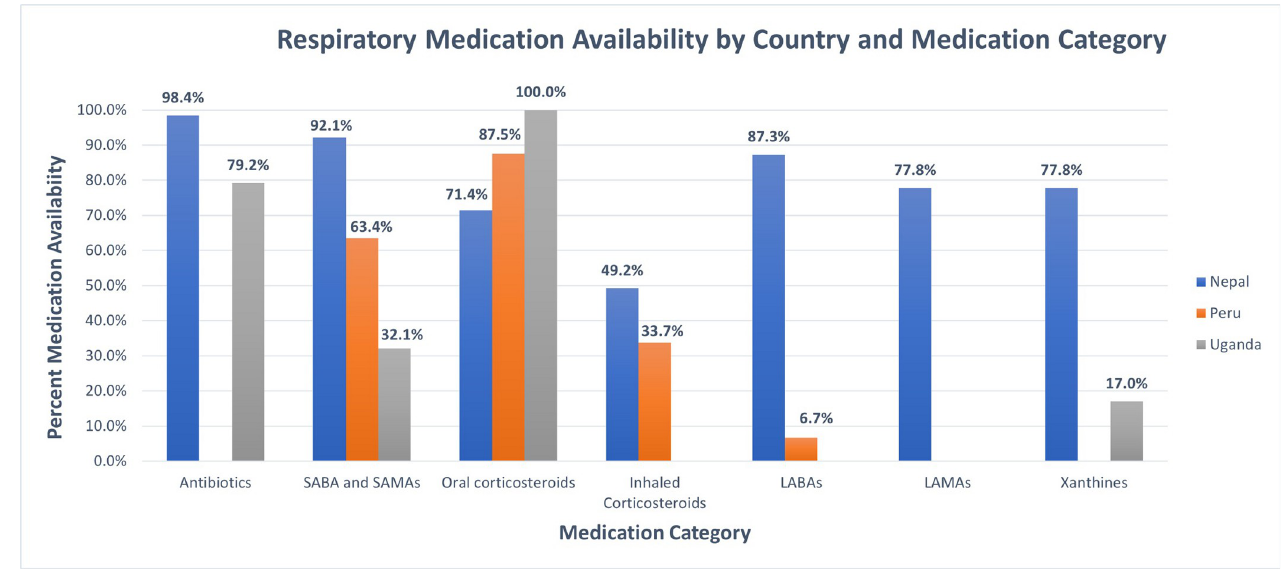
Fig 2. Percent availability of respiratory medicine stratified by medication category. Percent availability compared across sites by medication category. Note LAMAs, Antibiotics and Xanthines not surveyed in Peru.